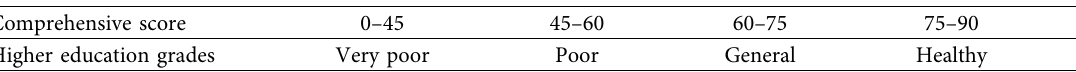
Table 3: Rating level.